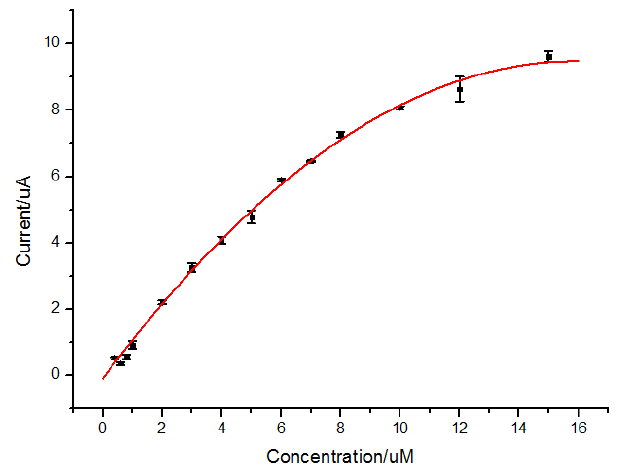
Figure 7. Relationship between peak current and quercetin